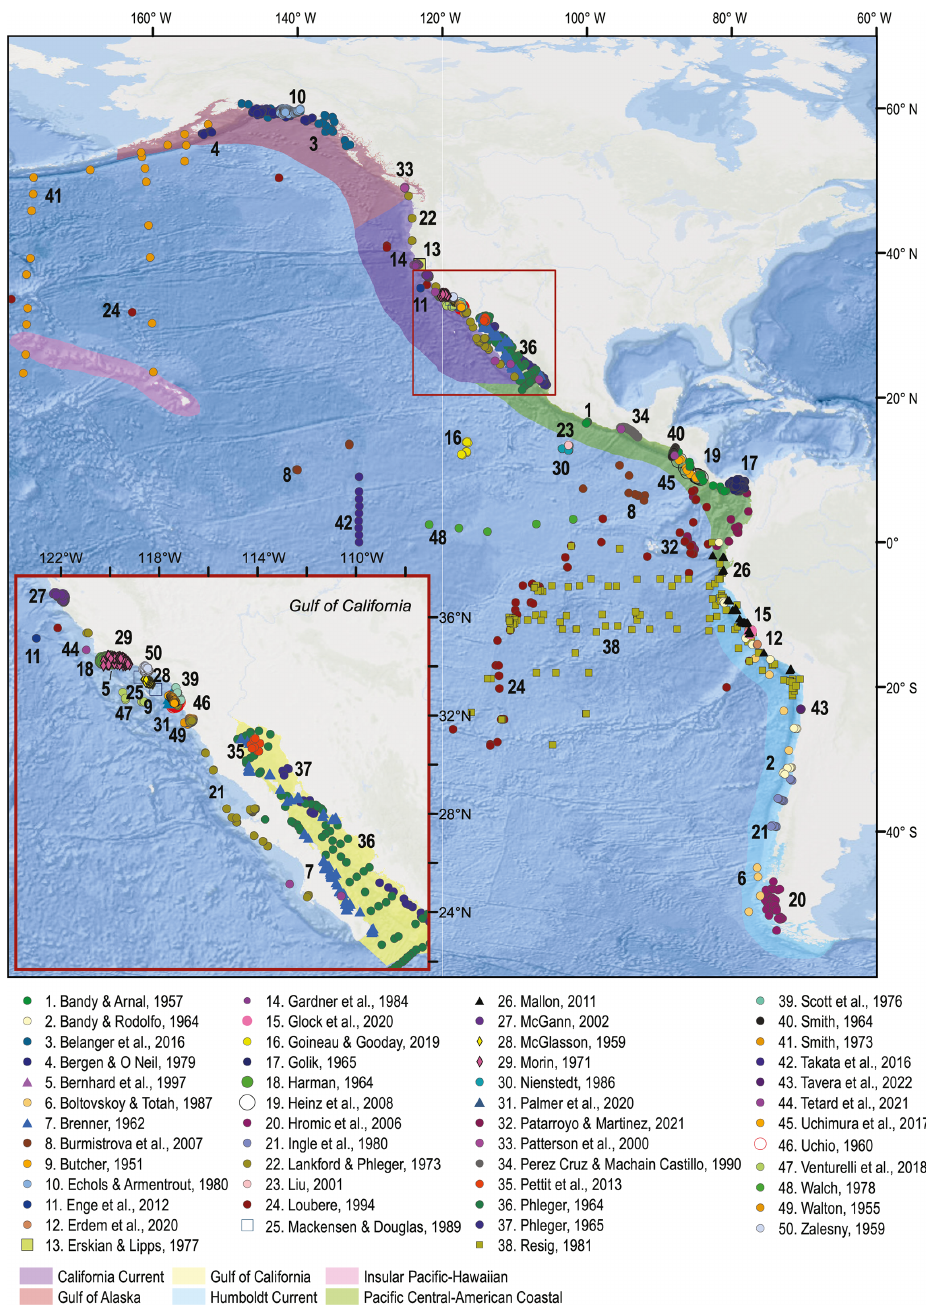
Figure 1. Spatial distribution of the samples comprising the BENFEP_v1 database. The numbers refer to each author’s dataset (see Table A1 for additional information). The shaded areas represent the large marine ecosystems of the eastern Pacific overlapping BENFEP_v1. The map was made using ArcGIS software (version 10.8.2). The global relief model integrates land topography and ocean bathymetry using information from Esri, Garmin, GEBCO, NOAA NGDC, and other